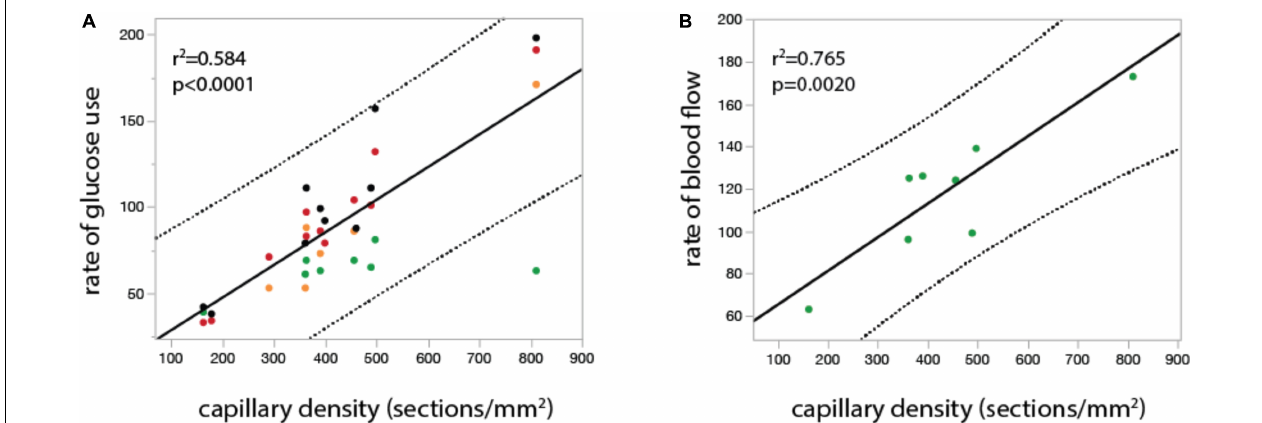
FIGURE 4 | In the undisturbed waking state, local rates of glucose use and blood flow vary linearly across rat brain sites with local capillary density. Graphs show local rate of glucose use ( A , in µ mol.100mg − 1 .min − 1 ) and local rate of blood flow ( B , in ml. 100mg − 1 .min − 1 ) plotted as a function of local capillary density (measured as number of capillary sections per mm2) in different structures in the rat brain in the undisturbed waking state. Both relationships are well fit by linear functions (r 2 and p -value shown). Data from McCulloch et al. (1982), Nakai et al. (1990), Kuschinsky and Paulson (1992), and Levant and Pazdernik (2004), provided in Supplementary Table 2